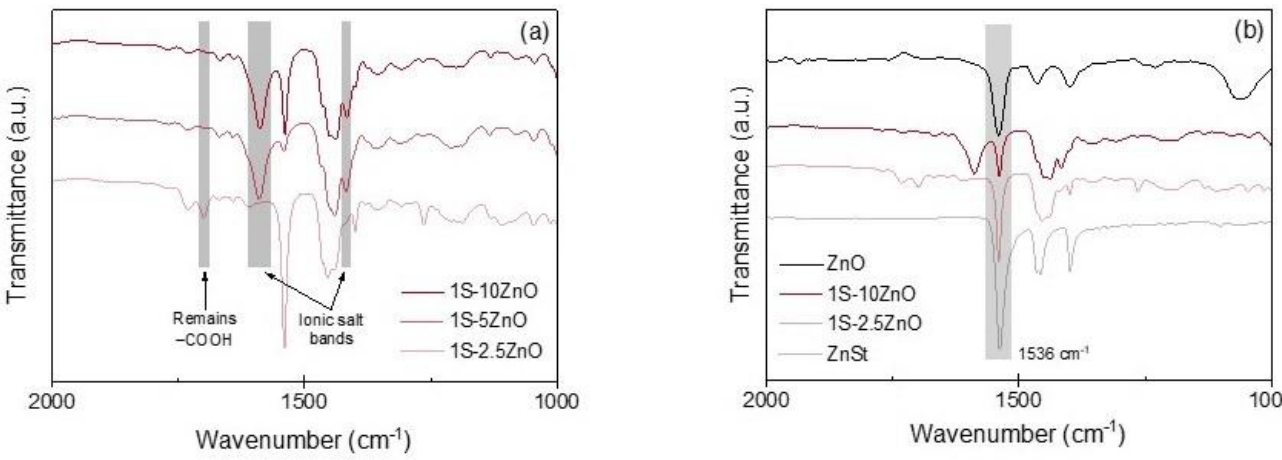
Figure 5. ( a ) ATR-IR spectra of dual networks compounds; ( b ) ATR-IR spectra of 1S-2.5 ZnO and 1S-10 ZnO compounds with ZnO and zinc stearate (ZnSt) powder.